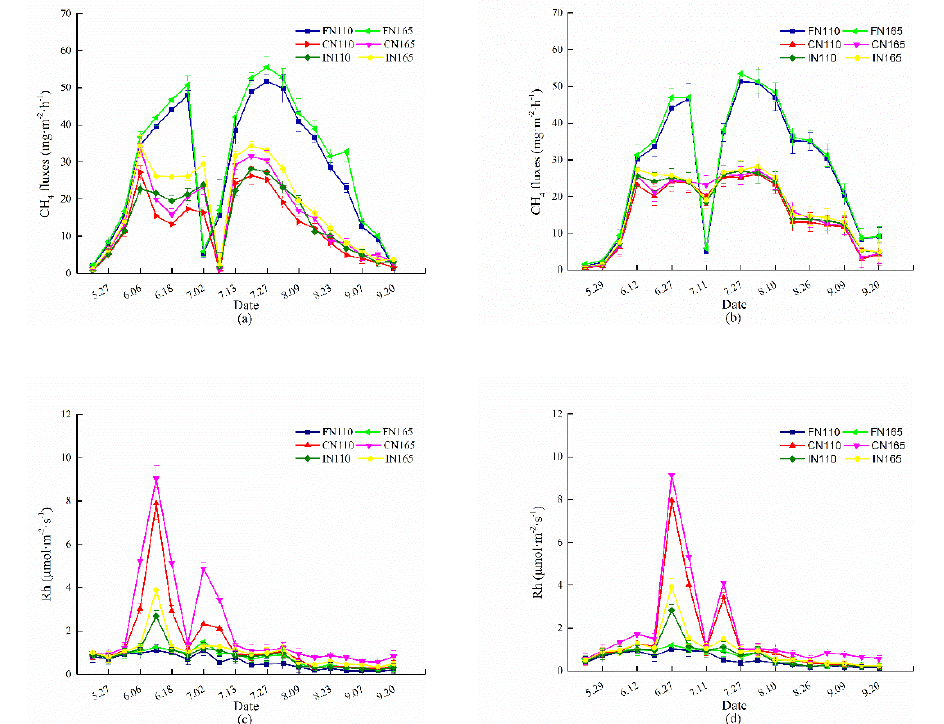
Figure 3. Changes in ( a ) CH 4 fluxes and ( c ) Rh in 2018 and changes in ( b ) CH 4 fluxes and ( d ) Rh in 2019 of paddy field after the implementation of water-saving irrigation.